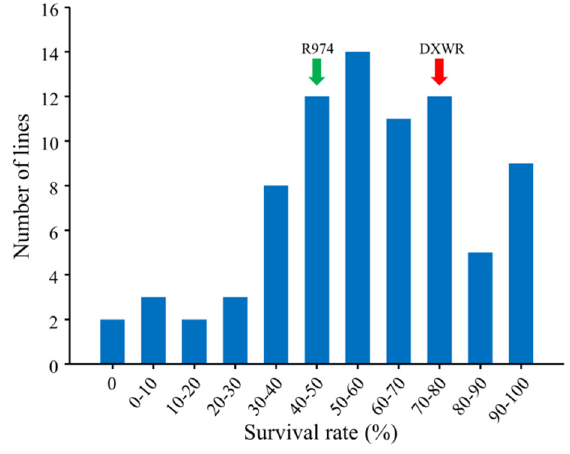
Figure 4. Survival rates of chromosome segment substitution line seedlings subjected to 200 mM NaCl stress. The data represents the average of two independent experiments.